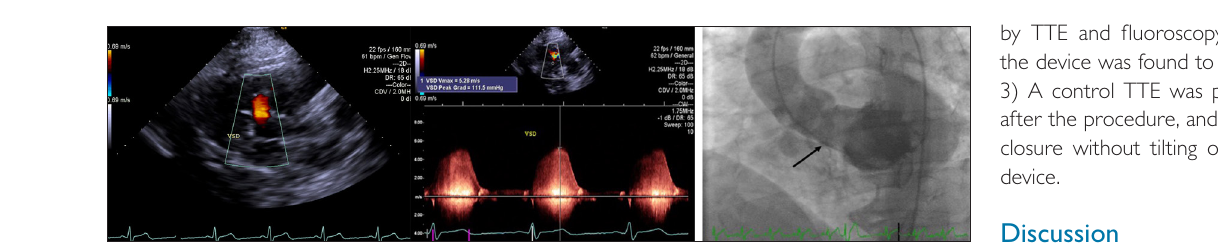
Figure 1. (top left) Transthoracic echocardiogram (TTE) demonstrates muscular ventricular septal defect (VSD) in the parasternal long axis view, (top right) continuous wave Doppler probing demonstrates VSD in TTE, (bottom middle) left ventriculogram demonstrates a small muscular VSD in the left anterior oblique projection.